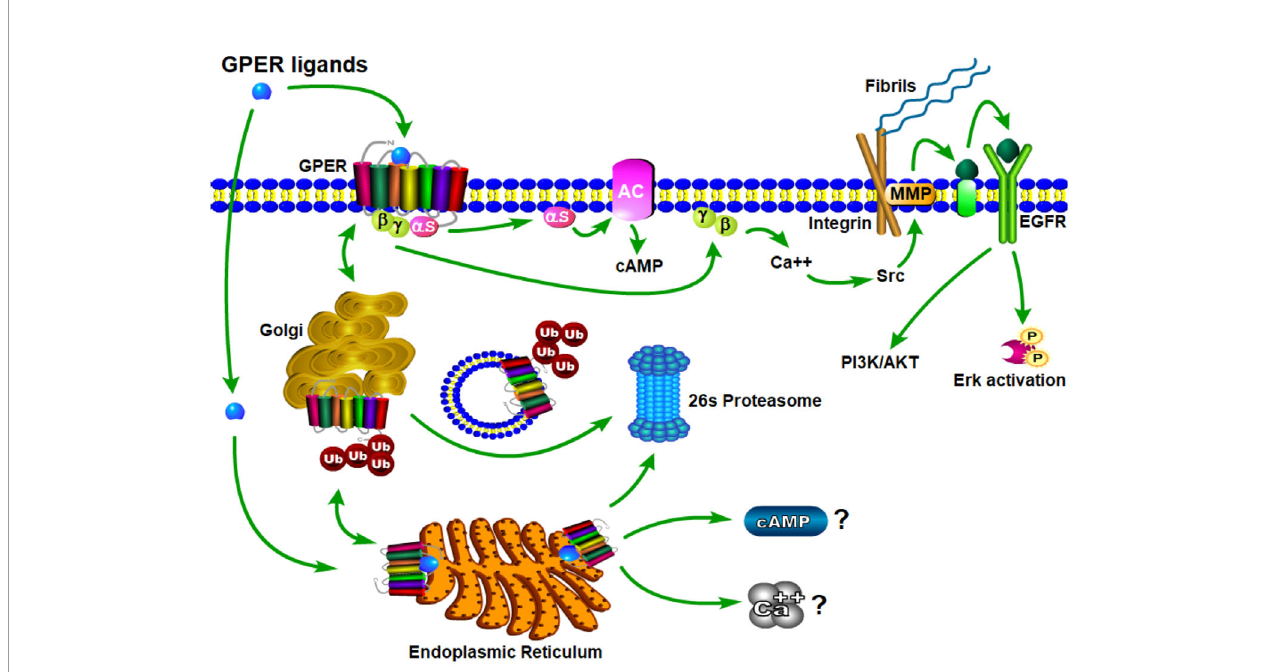
FIGURE 3 | Schematic model of GPER traf fi cking and signaling. Nascent GPER is biosynthesized in the endoplasmic reticulum (ER) where it undergoes carbohydrate addition, editing and dimerization prior to forward traf fi cking through the Golgi apparatus during its transport to the plasma membrane. Misfolded GPER is polyubiquitinated and degraded at the 26S-proteasome. At the plasma membrane GPER exists as a high af fi nity GDP-coupled G abg heterotrimer. Upon engagement of estrogenic ligands, GPER assumes an activated con fi rmation resulting in the dissociation of G a s and G bg subunit proteins, which in turn, stimulate adenylyl cyclase and integrin-dependent release of membrane-tethered EGF-ligands, respectively. Independent studies evaluating retrograde traf fi cking of GPER suggest that it undergoes constitutive endocytosis and degradation via a ubiquitin-transGolgi-proteasome pathway. It is not yet clear whether sustained GPER signaling is observed from intracellular receptor (question